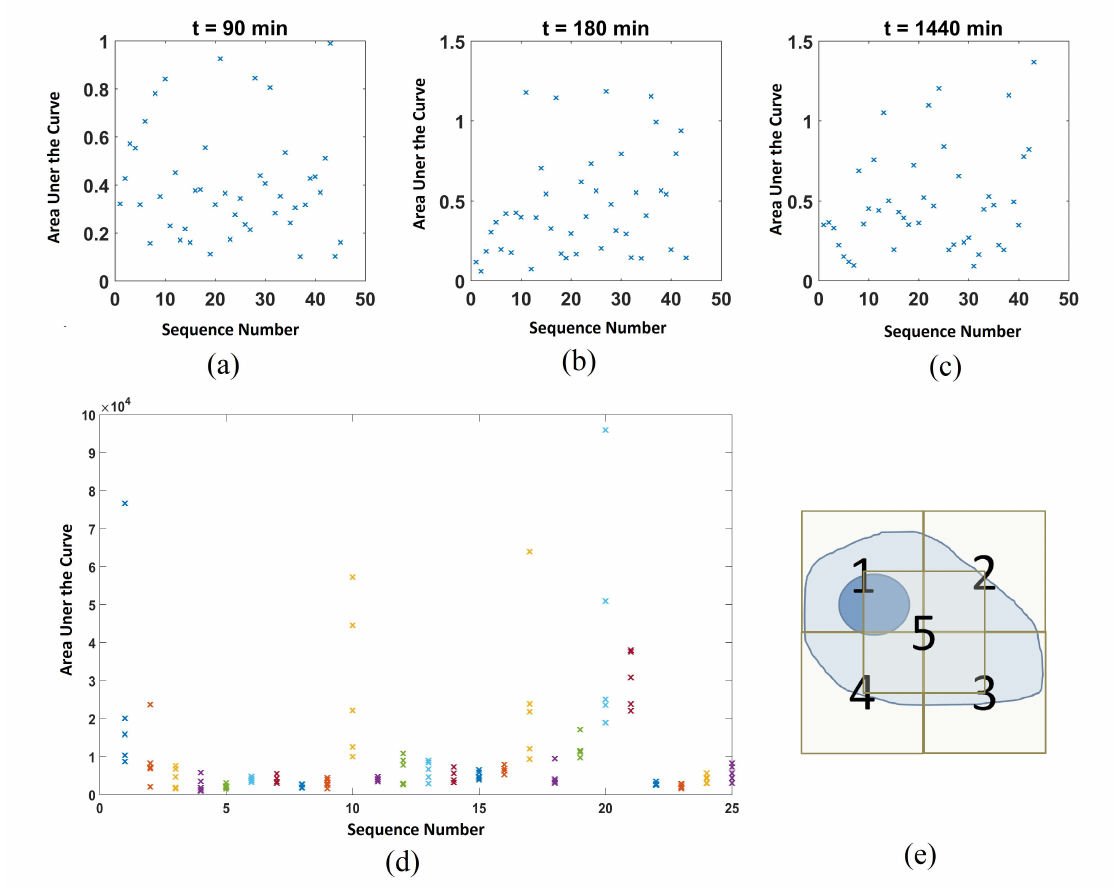
Figure A2. Distribution of the amount of lipid taken up by cells. Top row showing the example single point results of area under the curve against corresponding event number for cells treated with D31-PA only under normaoxic conditions, at time point ( a ) 90 min, ( b ) 180 min, and ( c ) 1440 min. ( d ) Representative plot for the area under the 2106 cm − 1 peak at the five measurement locations in each cell at t = 60 min. ( c ) Corresponding schematic of the locations of the five measurements taken in the